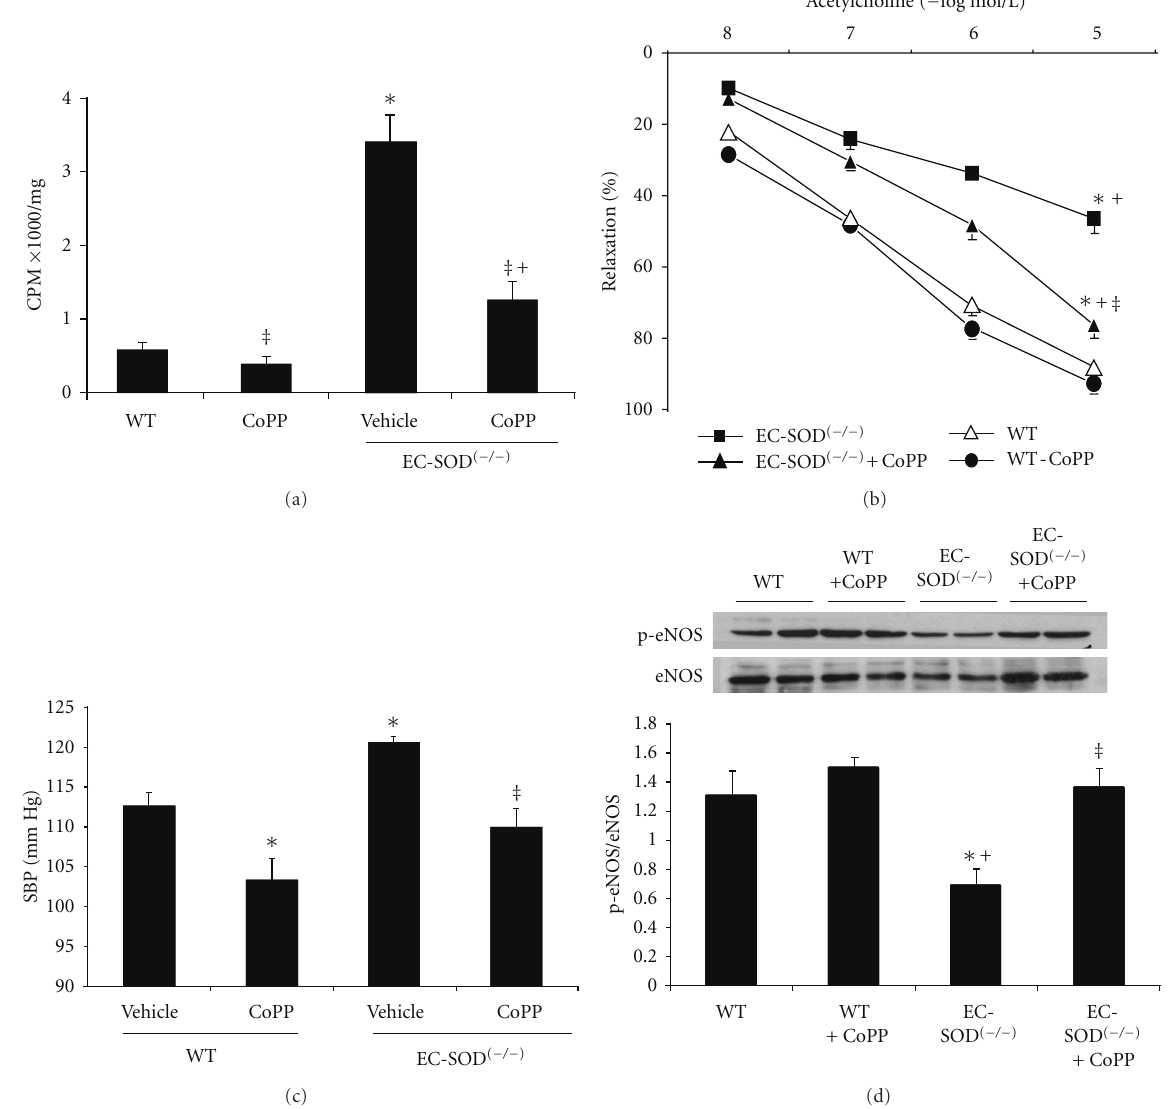
Figure 3: (a) Superoxide levels in femoral arteries of WT mice, EC-SOD ( − / − ) mice, and mice injected with CoPP. Superoxide levels were determined as described in methods. Results are mean ± SE, n = 4; ∗ P < 0 . 01 versus WT, ‡ P < 0 . 01 versus EC-SOD ( − / − ) ; + P < 0 . 05 versus WT + CoPP. (b) Dose-response curves for acetylcholine-induced vascular relaxation after preconstriction with phenylephrine. Results are mean ± SE, n = 4; ∗ P < 0 . 05 versus WT, ‡ P < 0 . 05 versus EC-SOD ( − / − ) , + P < 0 . 05 versus WT + CoPP, and (c) systolic blood pressure measurements at the completion of the study ( n = 4). Mice were injected with CoPP once a week as described in Methods. Blots are representative of four separate experiments. Results are expressed as mean ± SE, ∗ P < 0 . 05 versus WT, ‡ P < 0 . 01 versus EC-SOD ( − / − ) , + P < 0 . 05 versus WT + CoPP mice, and Western blot and densitometry analysis of (d) eNOS and